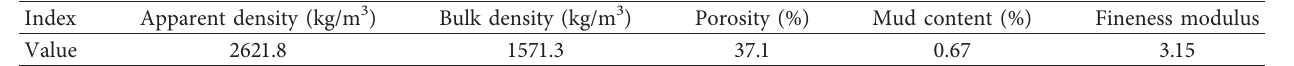
Table 1: Physical index of the back-filled sand.